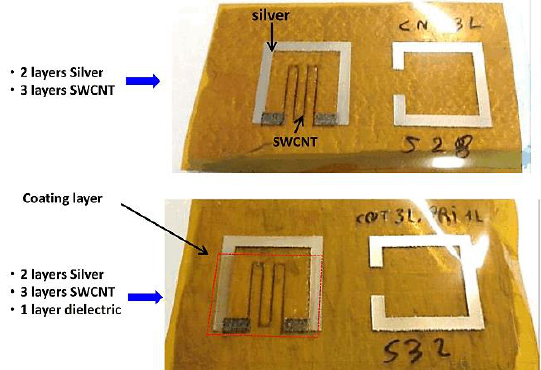
Figure 7. View of the fully inkjet-printed sensor on a polyimide material. The bottom figure contains an added see-through covering film on top of the susceptible deposit [51].